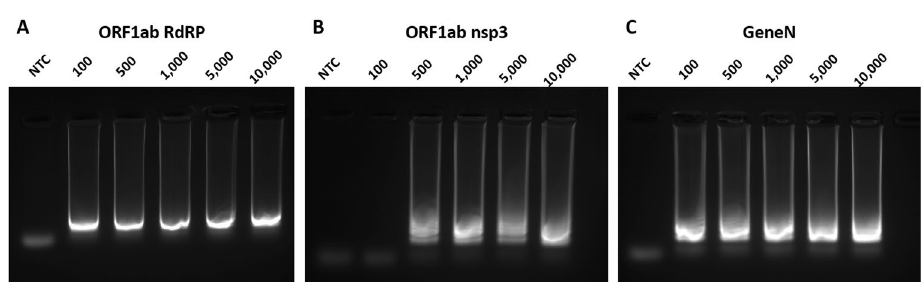
Figure 2. Gel electrophoresis analysis of LAMP assays. Representative gel picture is shown for ( A ) ORF1ab RdRP, ( B ) ORF1ab nsp3 and ( C ) Gene N in LAMP assays, using a dilution series of positive DNA control ranging from 100 copies to 10,000 copies. NTC (no template control) is used as a negative control. N = 3 biological